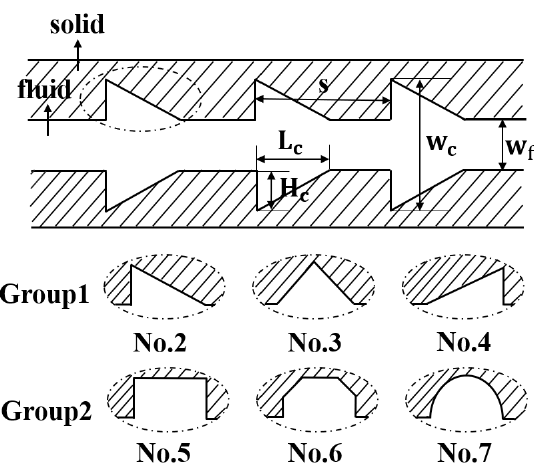
Figure 1. Structure of microchannel heat sink.